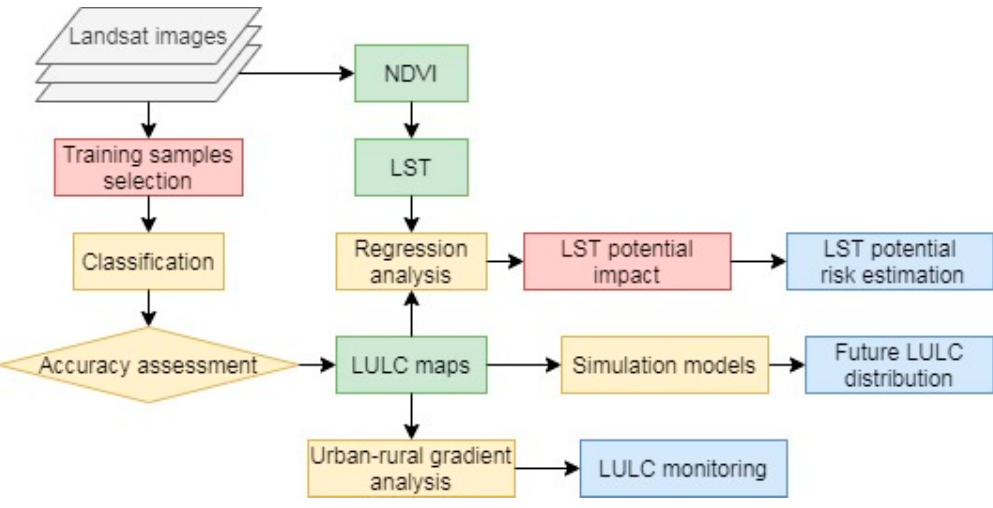
Figure 2. The workflow of this study.